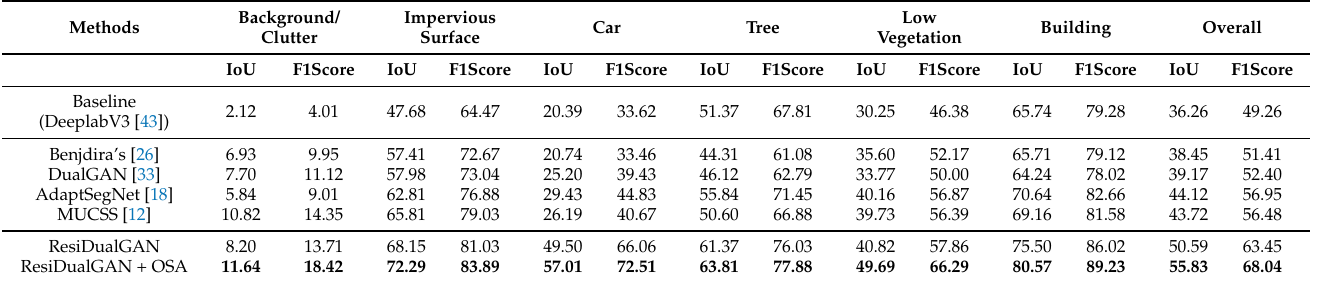
Table 1. The quantitative results of the cross-domain semantic segmentation from PotsdamIRRG to Vaihingen.